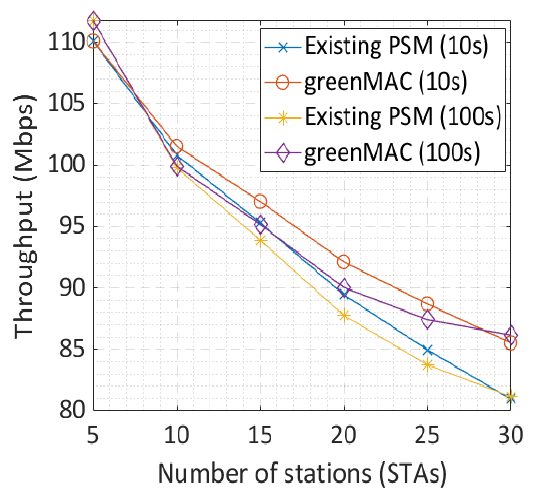
Figure 5. Throughput (Mbps) comparison of the proposed green MAC protocol and the existing PSM mechanism.